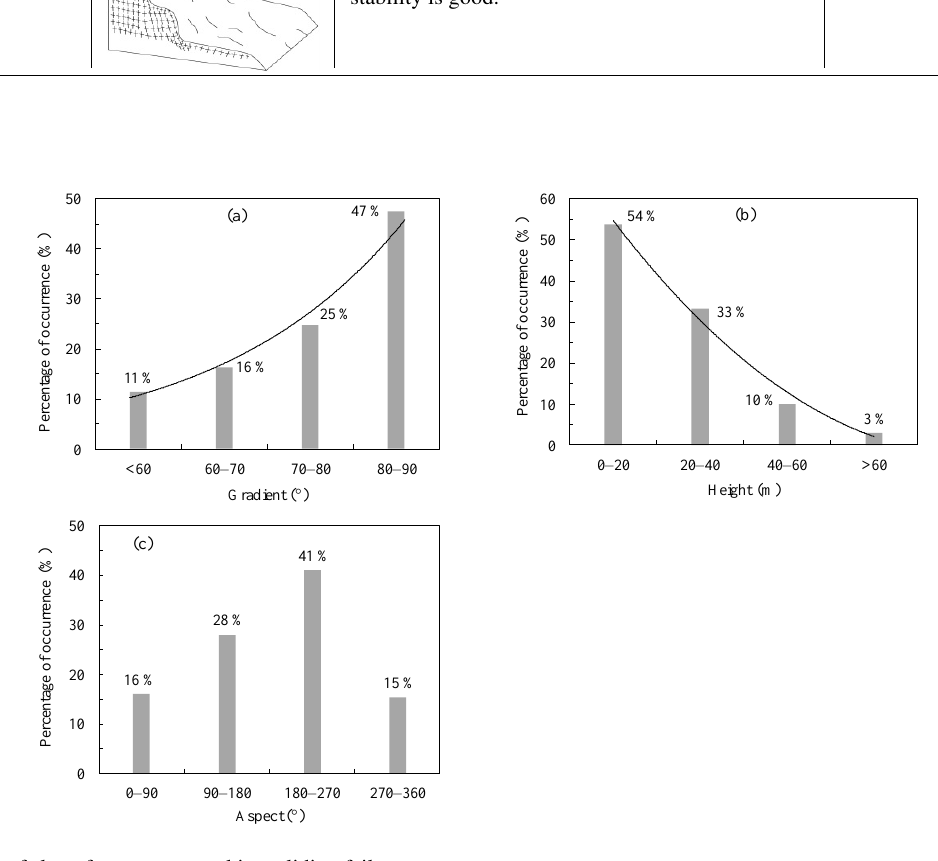
Figure 4. Effect of slope features on cracking–sliding